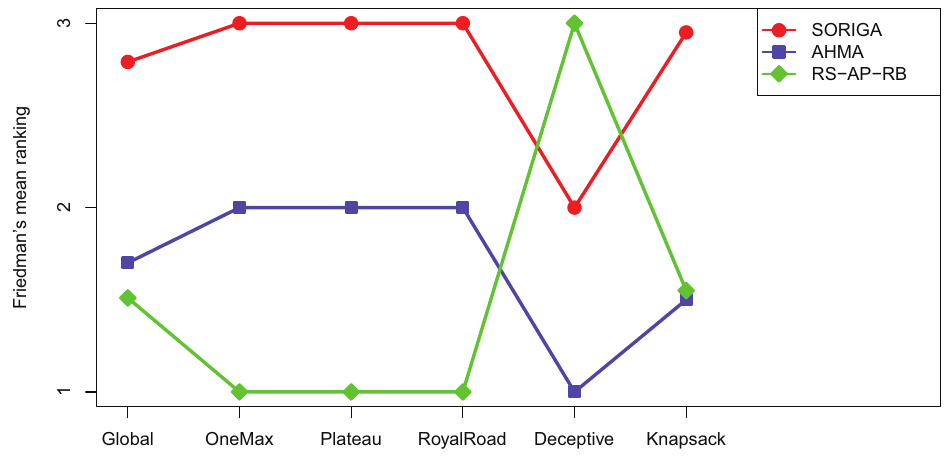
Fig. 6. Mean ranking provided by the Friedman’s non- parametric test when the best portfolio variant (RS-AP-RB) is compared against SORIGA and AHMA. Each series rep- resent the mean raking (Y axis) for a specific method when all problems are considered (Global) and for each problem (OneMax, Plateau, RoyalRoad, Deceptive and Knapsack).